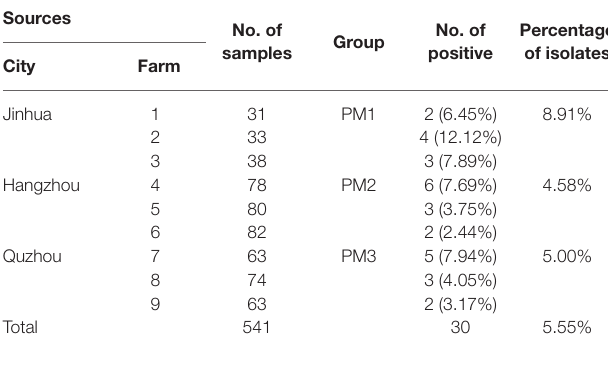
TABLE 1 | Sampling design and prevalence of Proteus mirabilis from different sources.